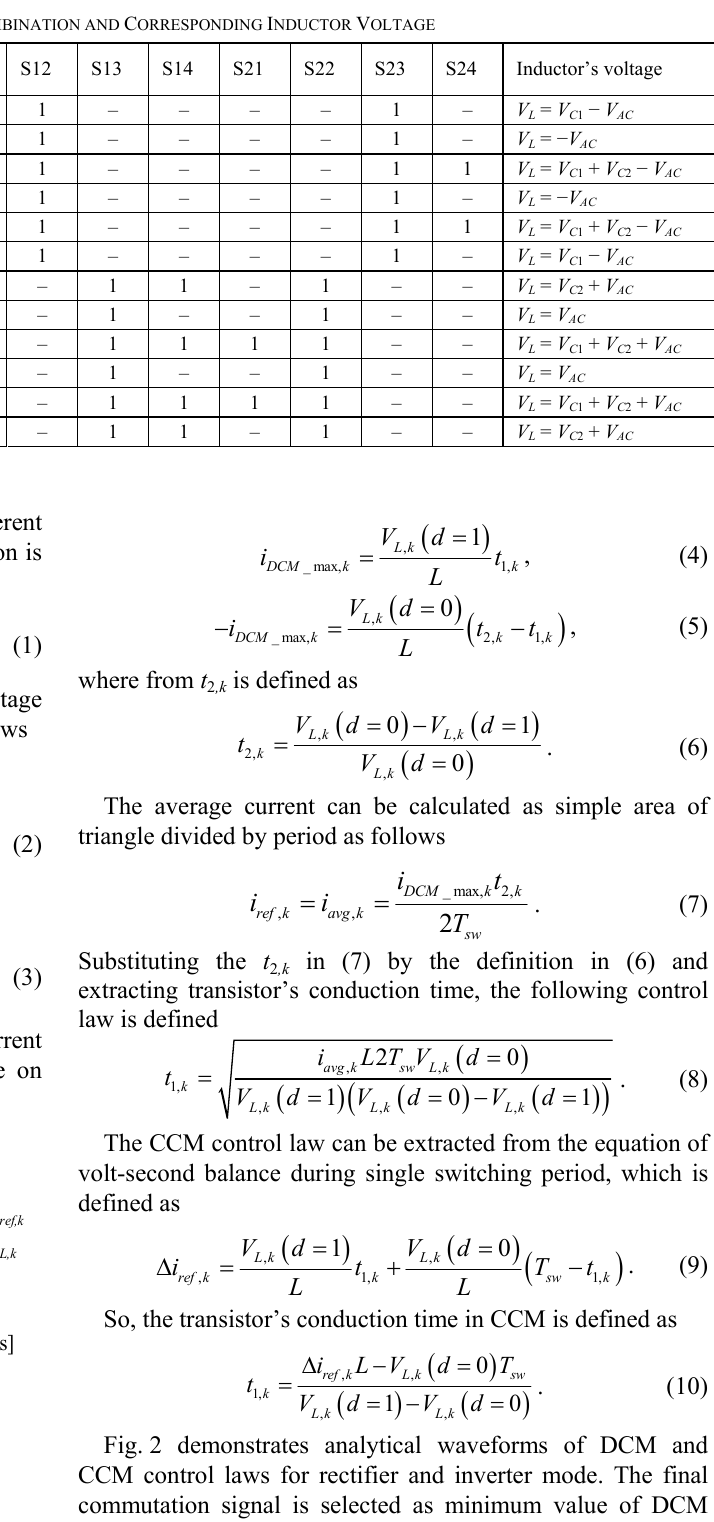
Fig. 1. Inductor’s discontinuous and continuous current modes.